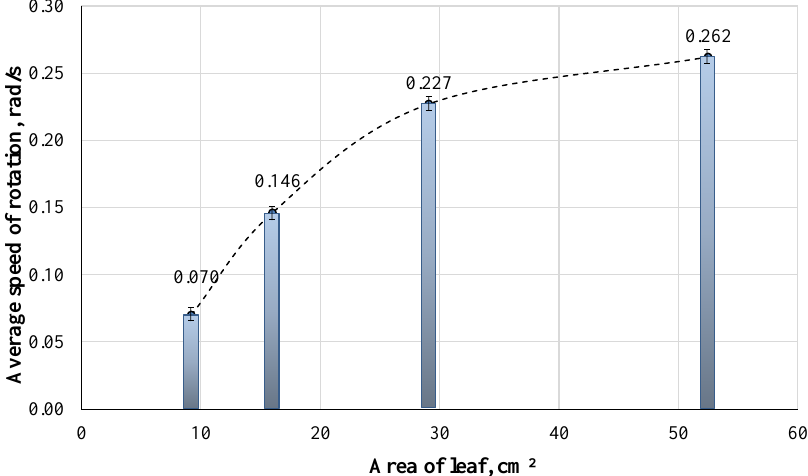
Figure 8. The relationship between the broad leaved lime ( Tilia platyphyllos Scop ) leaf blade angular velocity and active surface area ( n = 6).